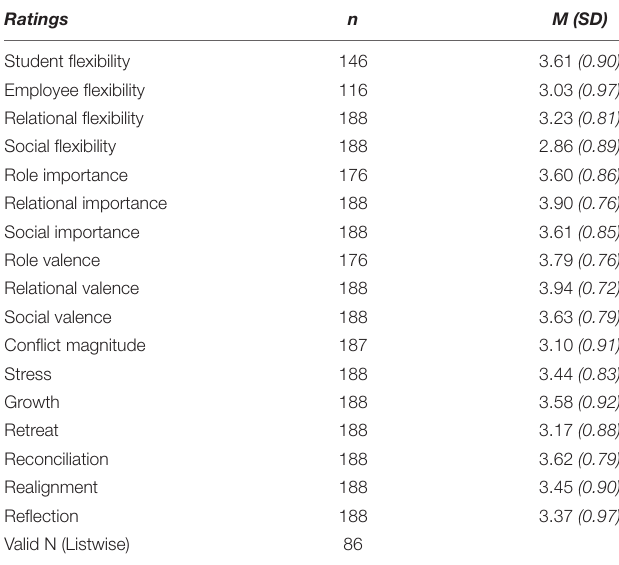
TABLE 3 | Means and standard deviations for identity characteristics, and the experience and management of identity conflict (Study 3). Ratings n M (SD)